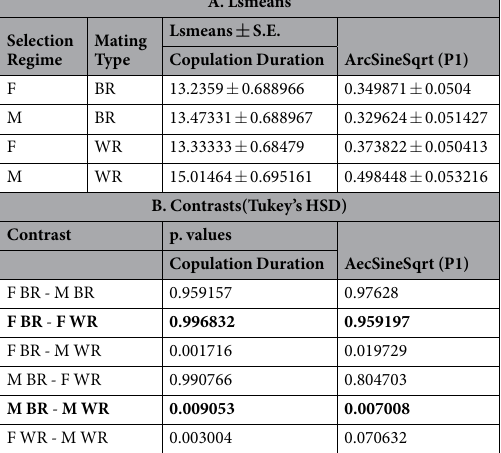
Table 3. A. Least square means ± S.E. values for Copulation Duration and P1. B. P values obtained through pairwise contrast using Tukey’s HSD. The important contrasts have been highlighted in bold.